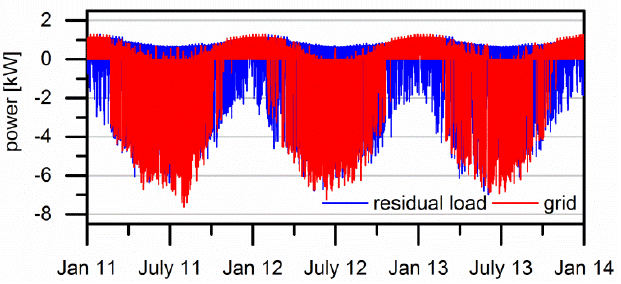
Figure 9. Power of residual load and grid exchange over the entire period under consideration.